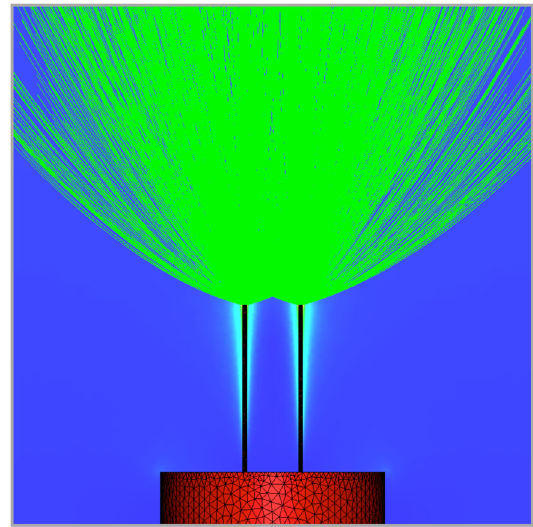
FIG. 18. PIC simulation of carbon fiber wires shown in Fig. 1. Space charge forces are included in the